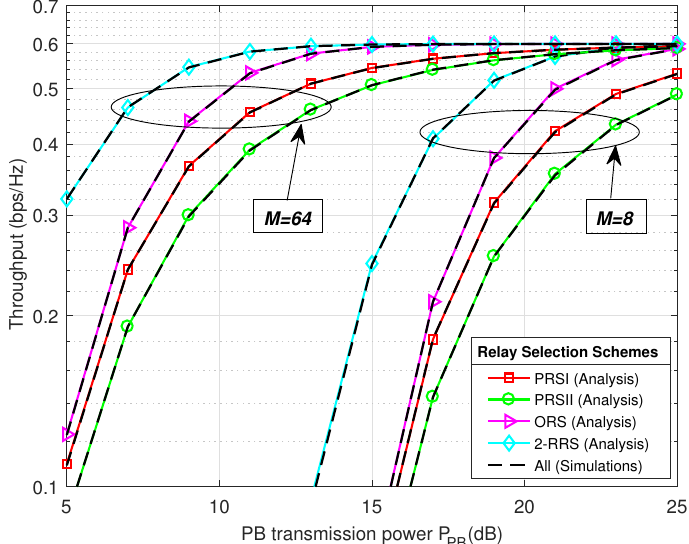
Figure 6. The system throughput performance comparison of the proposed 2-RRS scheme and that of the conventional ORS and PRS versus Power Beacon transmitted power P PB (dB) with M = { 8, 64 }